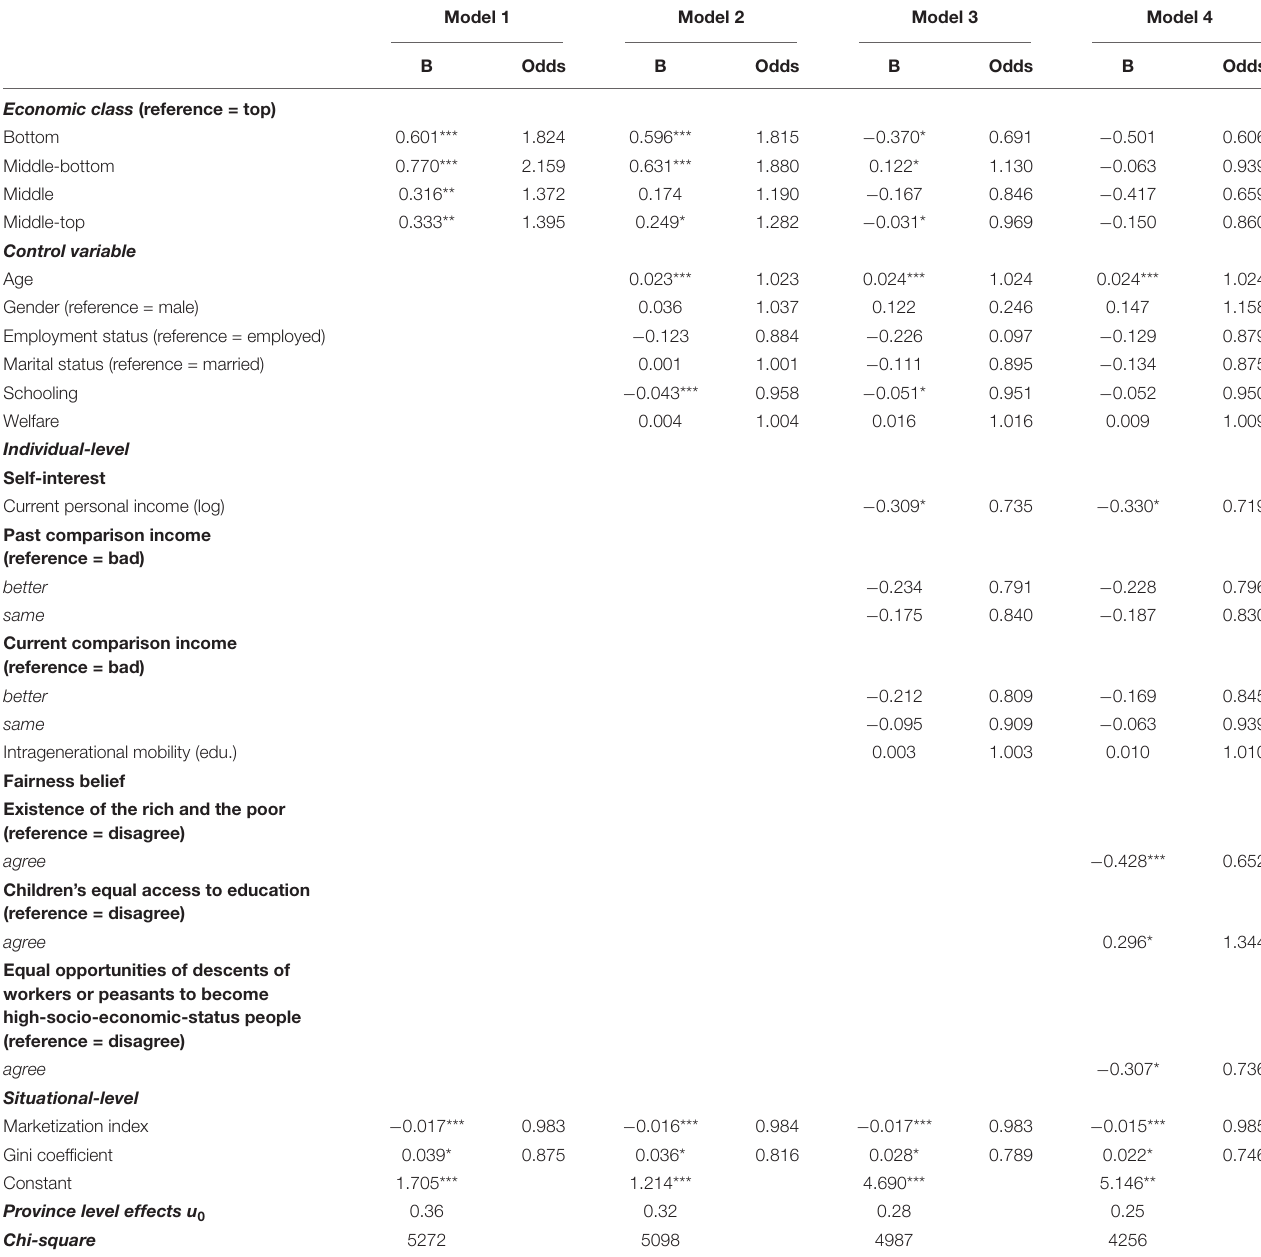
TABLE 2 | Hierarchical logistic regressions coefficient predicting odds of supporting establishing unemployment subsidy during the COVID-19 period on individual-level and situational-level variables in